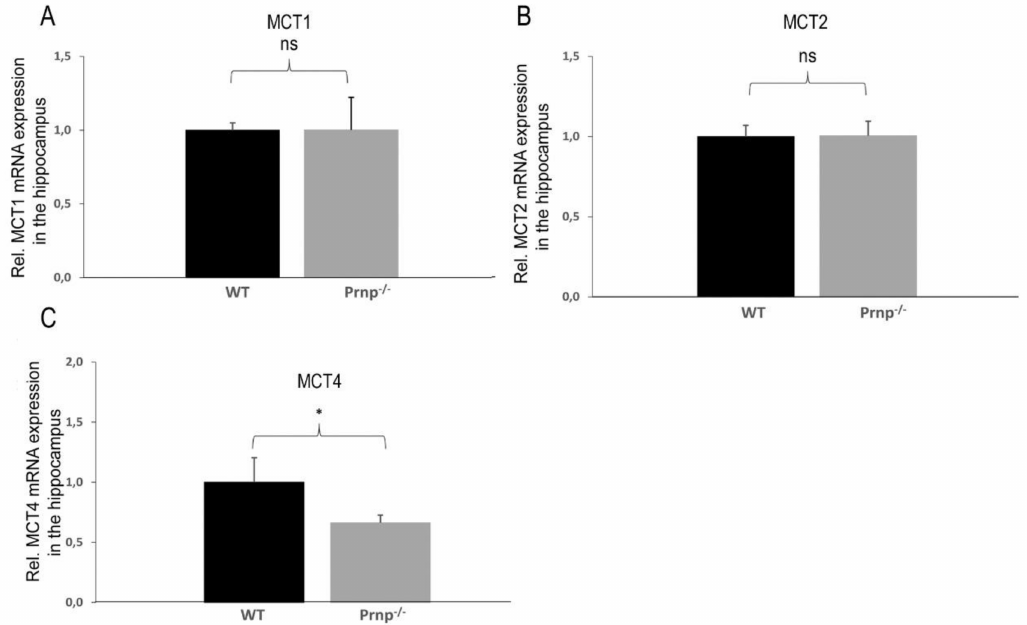
Figure 4. ( A – C ). Differential mRNA expression of MCT1 , MCT2 and MCT4 in the hippocampus of WT and Prnp − / − mice. Quantification of the mRNA expression revealed a lower MCT4 expression in the hippocampus of the Prnp − / − experimental group than in control group, while at the same time levels of MCT1 and MCT2 were unaltered. Sample size of WT group: n = 5; Prnp − / − group: n = 6. Displayed are means ± SEM. A p -value < 0.05 is considered as significant (*) and ≥ 0.05 as not significant